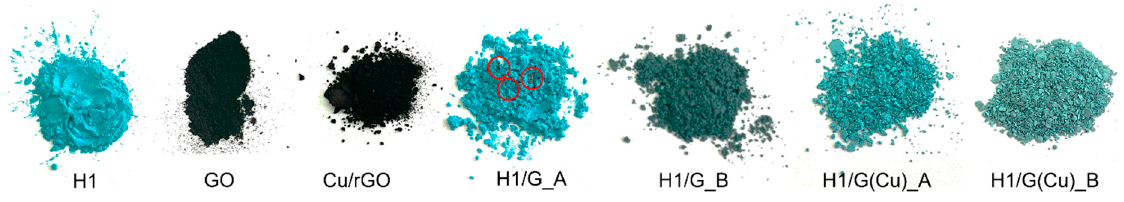
Figure 8. Pictures of HKUST-1/GO composites and their compounds alone. Red circles on the picture of H1/G_A indicate the black GO particles.